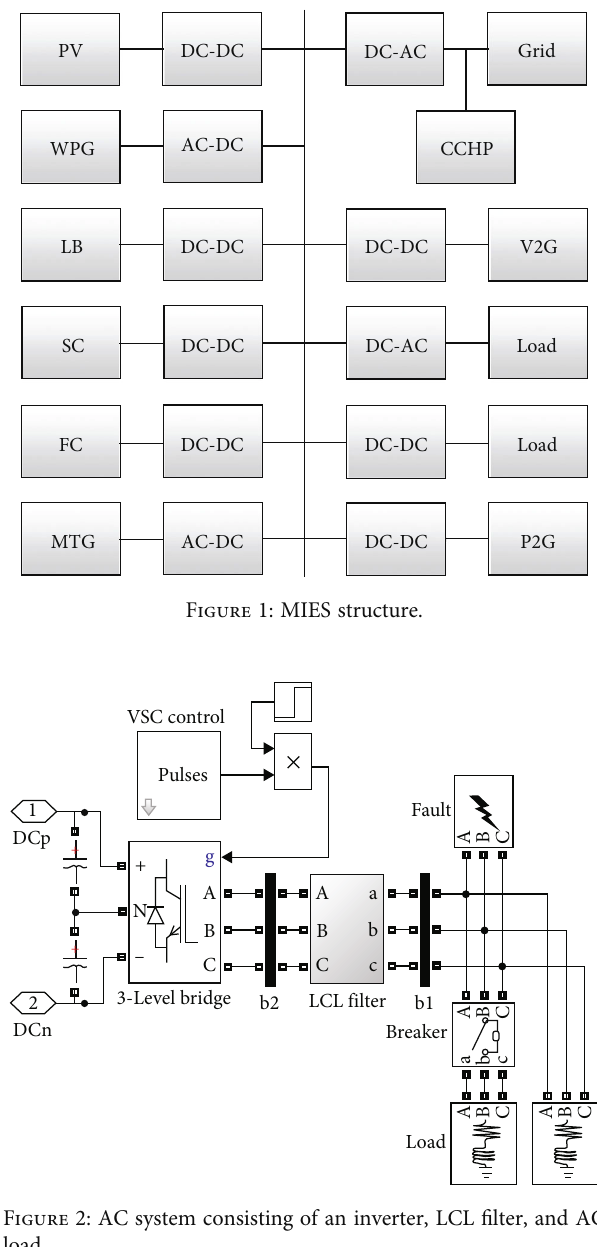
Figure 2: AC system consisting of an inverter, LCL fi lter, and AC